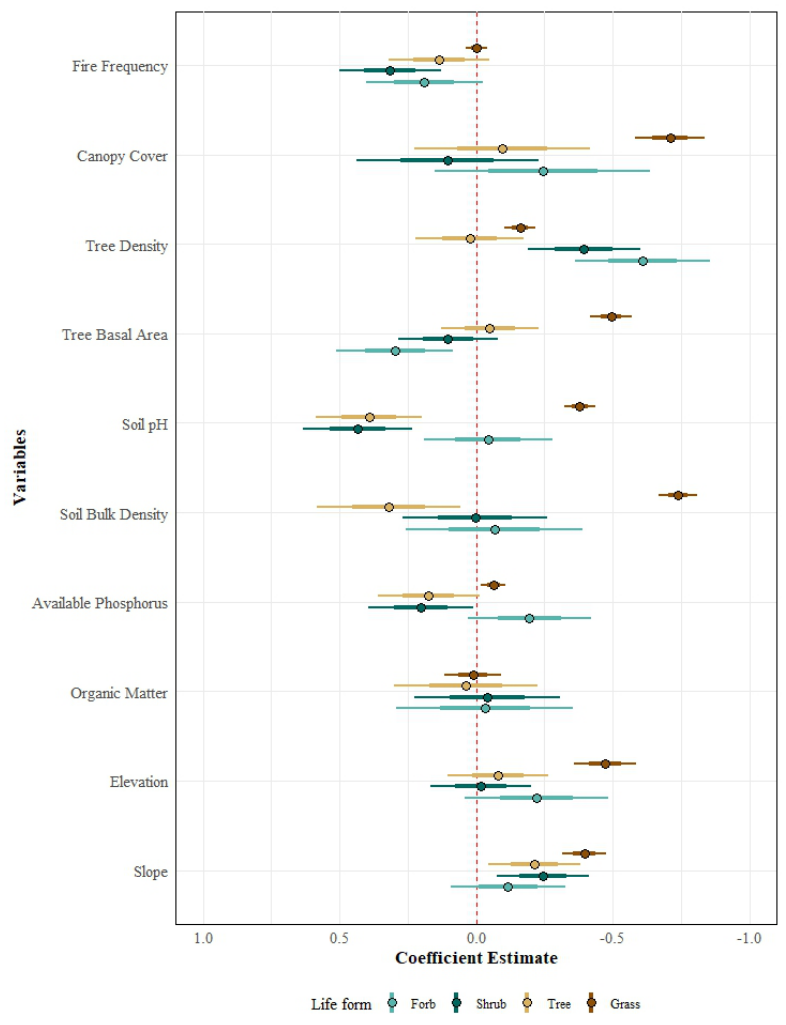
Figure 6. Coefficient plot showing the relative effect sizes of each environmental factor on forage availability in different life forms (denoted by different colors). The squares represent the mean of the coefficient estimate, and the lines represent the 95% confidence intervals. The red dashed line indicates no effect (coefficient =